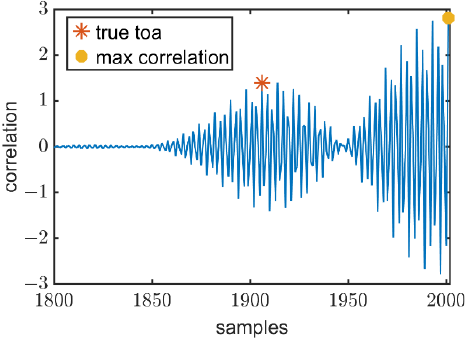
Figure 13. The time of arrival (TOA) is lagged due to the multipath effect.